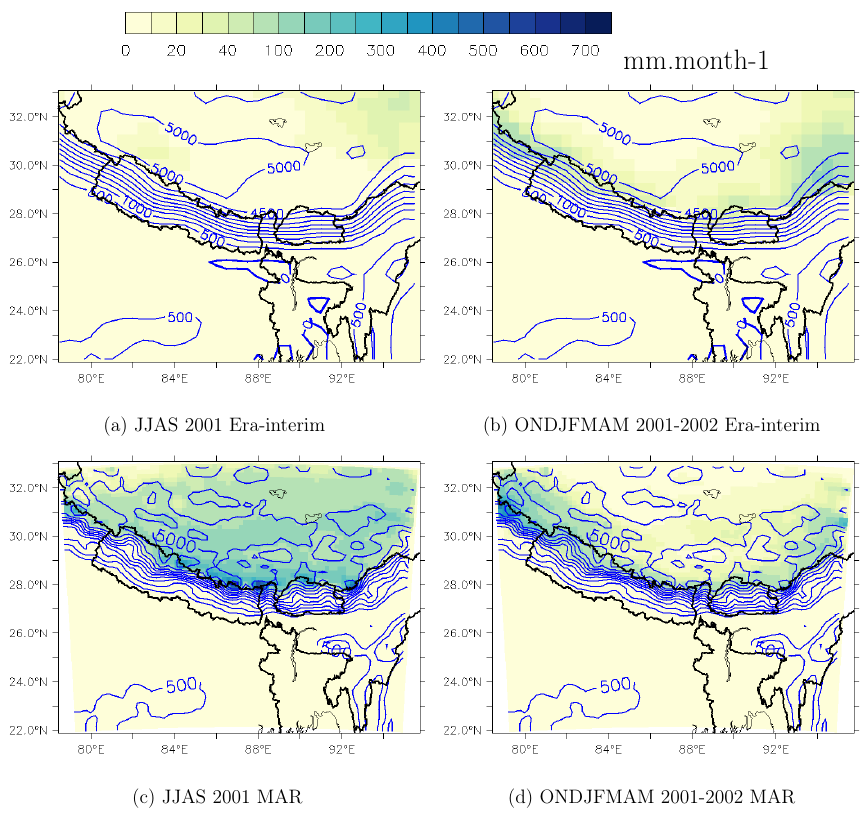
Fig. 7. Snowfall (mmmonth − 1 ): Estimated with ERA-INTERIM (a) during monsoon (JJAS) 2001, (b) during extra-monsoon period (OND- JFMAM) 2001–2002; simulated with MAR (a) during monsoon (JJAS) 2001, (b) during extra-monsoon period (ONDJFMAM) 2001–2002. 500m-spaced iso-lines show the model